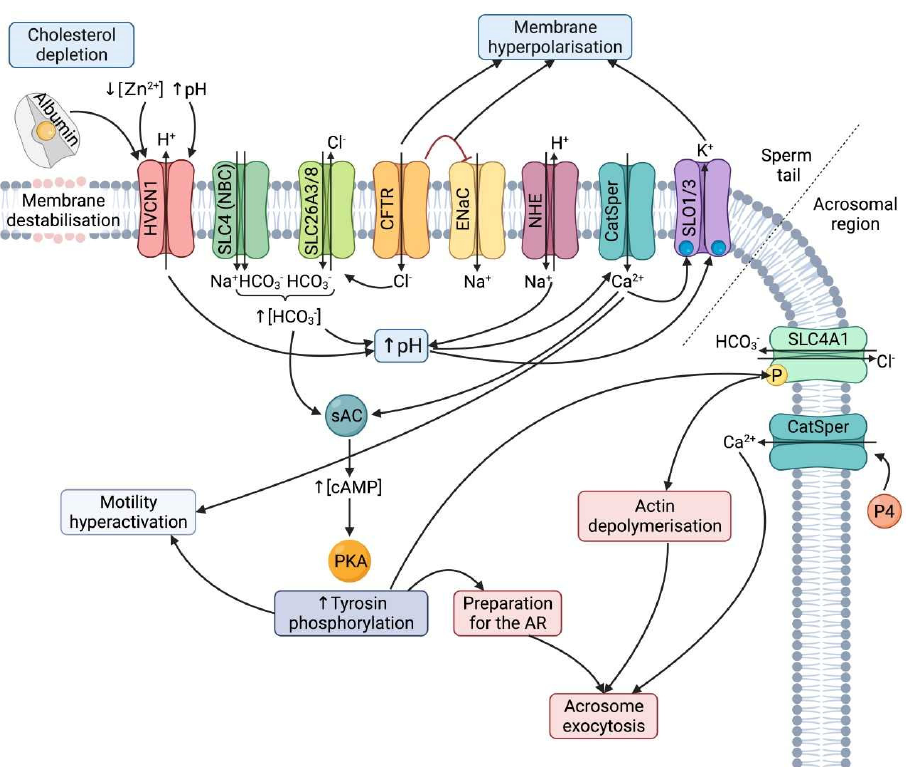
Figure 5. Membrane channels in sperm capacitation and the acrosome reaction. When sperm enter the female tract, the plasma membrane is partially destabilized because of cholesterol depletion. Albumin does not only contribute to cholesterol depletion, but also activates HVCN1. This channel is also activated by the higher pH in the female tract and the lower concentration of Zn 2+ compared to the male tract. One of the first events in the capacitation pathway is the activation of SLC4 (NBC) channels that contribute to the increase in bicarbonate concentration. This increase is also achieved through the cooperation of SLC26 channels with CFTR. The activation of CFTR inhibits ENaC chan ‐ nels, and these two events contribute to plasma membrane hyperpolarization. Intracellular pH al ‐ kalinization occurs in response to both HCO 3 − influx and H + efflux through the plasma membrane, which activates both CatSper and SLO channels. Both high pH and increased concentration of Ca 2+ activate the soluble adenylate cyclase (sAC), which increases cAMP levels and, in turn, PKA activity. The increase in tyrosine phosphorylation prepares the sperm for the AR, and hyperactivates sperm motility. In addition, downstream of the signaling pathways of tyrosine phosphorylation, SLC4A1 channels in the acrosome region are phosphorylated, which activates actin depolymerization in this region. The increase in progesterone levels that sperm encounter in the oocyte vicinity activates CatSper channels in the sperm head, which trigger the acrosome reaction. HVCN1 channels may also be activated by albumin, which is highly abundant in the uterine fluid (500 μ M) as compared to the seminal fluid (15 μ M) [161,164]. It has been reported that one albumin molecule can bind external HVCN1 residues linking S3 and S4 transmembrane segments of the two VSDs of one dimer, thus favoring channel opening [136,161]. Interestingly, while albumin has a high specificity for HVCN1 channels, it does not have this high affinity for other voltage ‐ gated channels; in the absence of albumin, HVCN1 activates slowly and shows fast deactivation, whereas albumin ‐ HVCN1 com ‐ plexes are characterized by fast activation, slow deactivation, and high current magnitude [161,165]. Such a regulatory effect has been reported to be similar between HVCN1 and HVCN1Sper variants [161]. In a recent study, Zhao et al. [161] demonstrated that the in ‐ cubation of non ‐ capacitated human sperm in the presence of albumin resulted in an in ‐ creased H + current efflux across HVCN1 channels, pH i alkalinization, and sustained Ca 2+